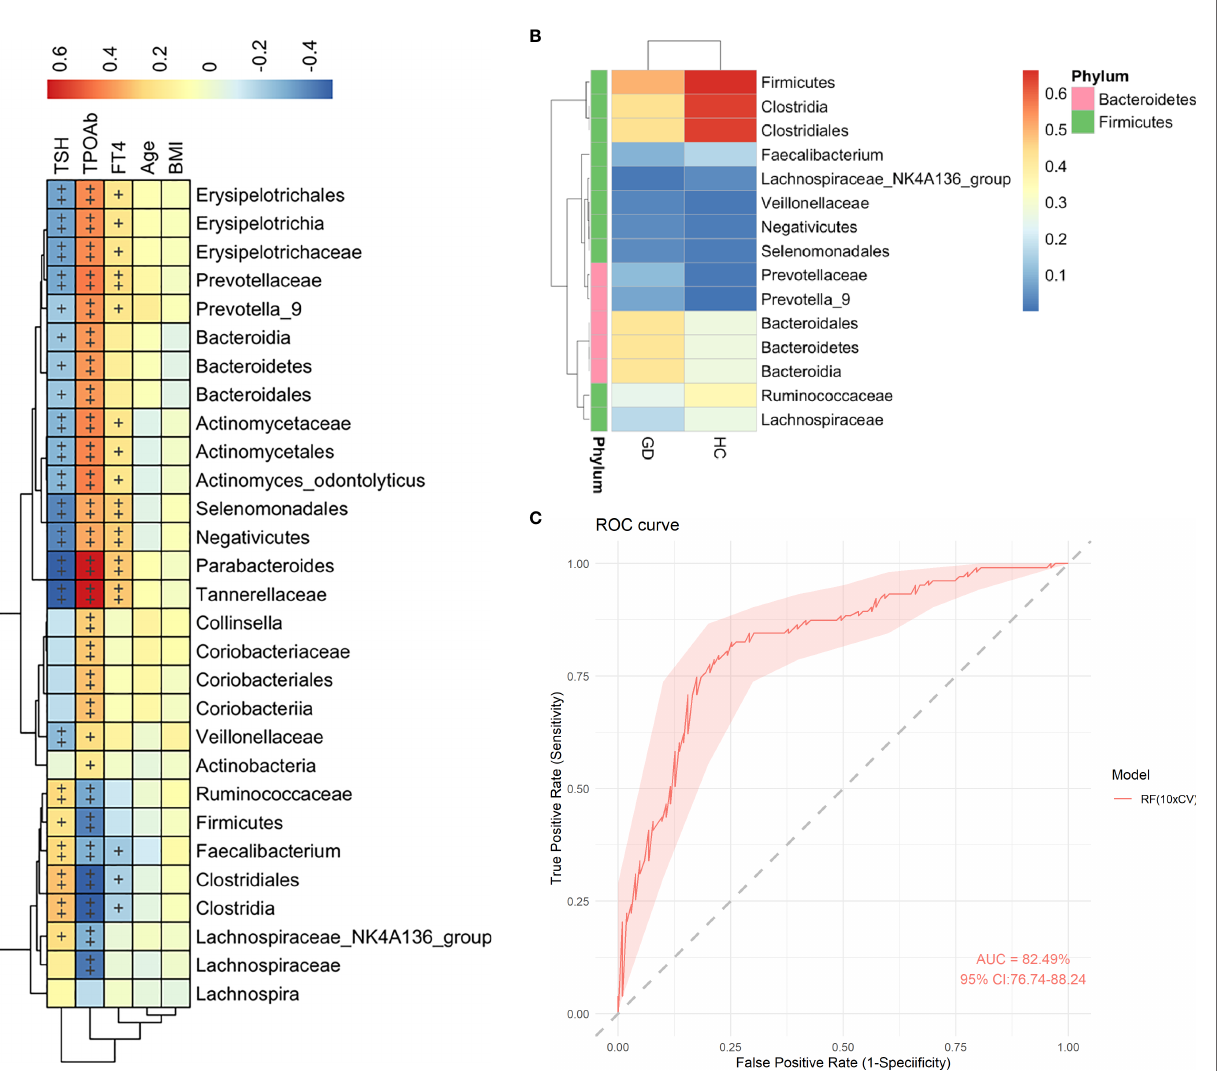
FIGURE 3 | Spearman correlation analysis of the gut microbiota with clinical parameters. Heatmap showing the relationships of altered 29 gut microbiota and 5 clinical parameters in healthy controls and GD patients. Color intensity indicates the magnitude of correlation. Red = positive correlation; blue = negative correlation. + p < 0.05, ++ p < 0.01. BMI, body mass index; FT4, free thyroxine; TSH, thyrotropin; TPOAb, thyroperoxidase antibody (A) . Heatmap analyses of the relative abundant of top 15 taxa from 29 gut microbiota. The heatmap plot depicts the relative abundance of each bacterial taxa (vertical axis) within each group (horizontal axis). The color of the spot in the right panel corresponds to the relative values of the taxa in each group (B) . Random forest analysis was used to classify GD patients and healthy controls based on the top 15 most abundant taxa. The performance of the random forest analysis was assessed with the AUC of the ROC curve. The light pink area indicates the 95% con fi dence interval (C)